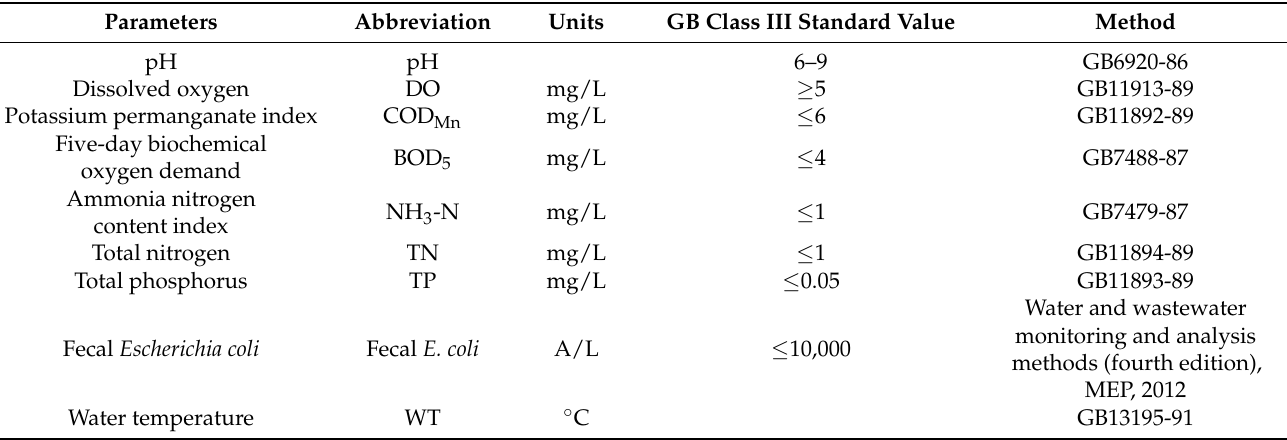
Table 1. Parameters; their corresponding abbreviations, units, and standard values for China